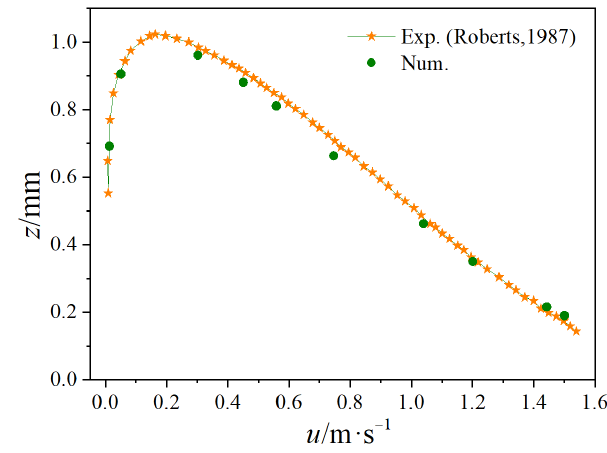
Figure 6. Velocity profile of mildly curved surface on u i = 10 [11].